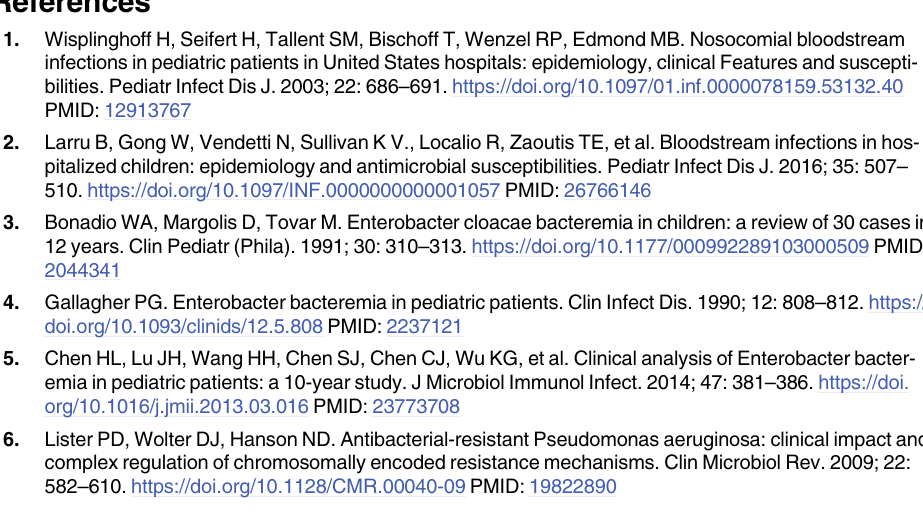
S1 Table. Demographic and clinical characteristics of pediatric patients with microbiologic failure following Enterobacter spp. bacteremia. CLABSI (Central-line associated